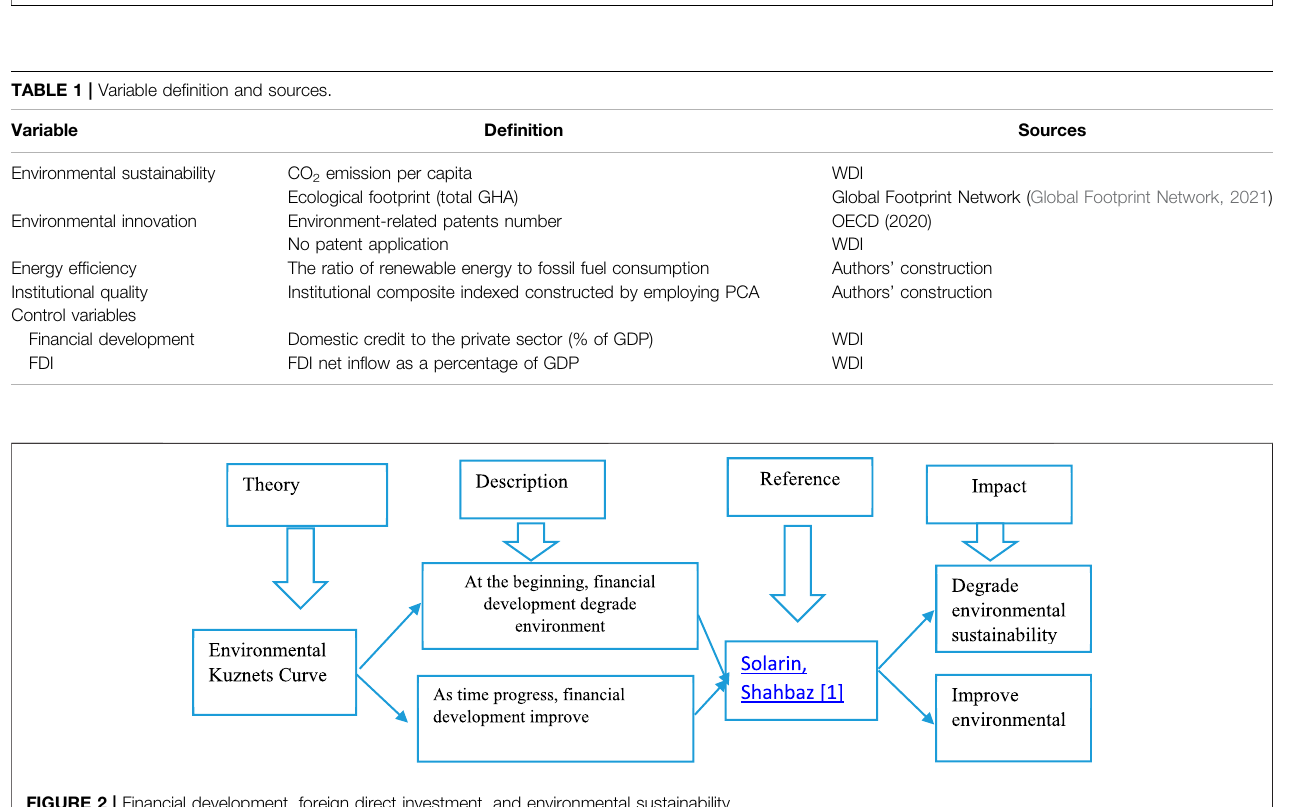
FIGURE 1 | Institutional quality and environmental sustainability.